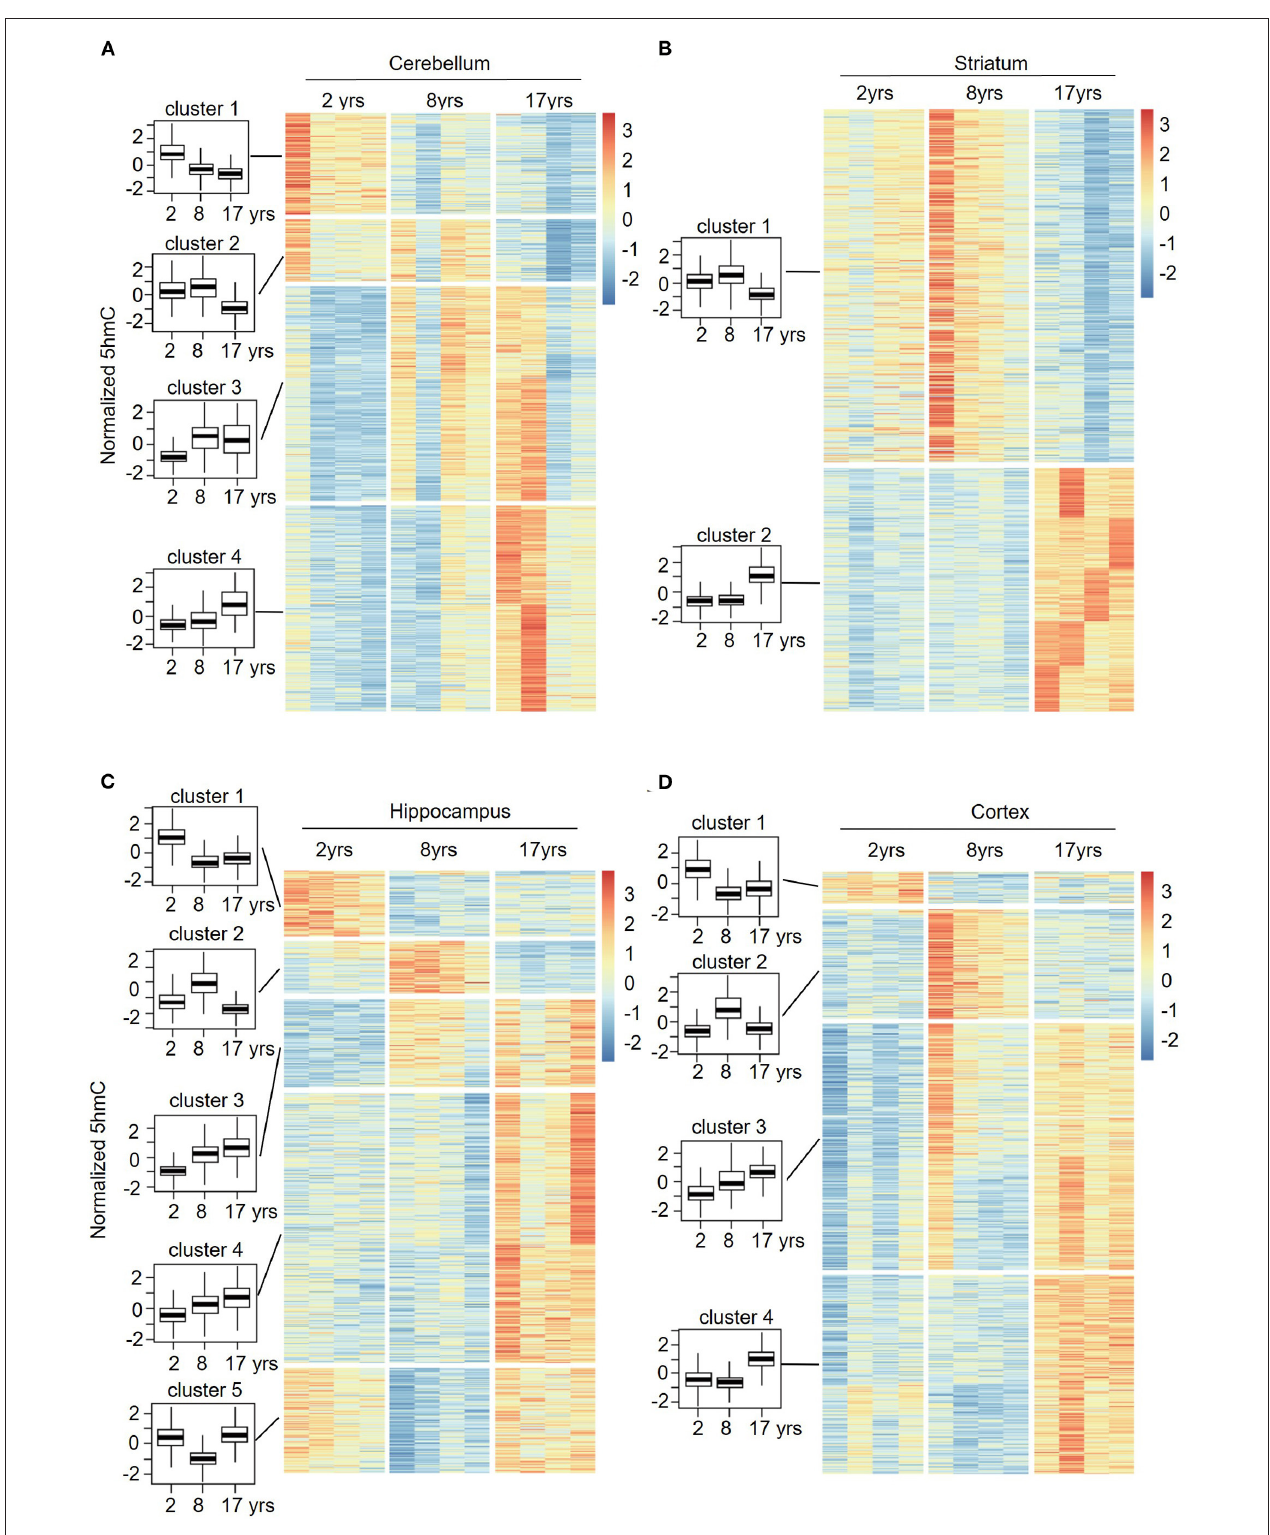
FIGURE 6 | Sequential features of 5hmC at cerebellum (A) , striatum (B) , hippocampus (C) , and cortex (D) during aging. Time-series analysis revealed 4 clusters in the cerebellum (A) , 2 clusters in the striatum (B) , 5 clusters in the hippocampus (C) , and 4 clusters in the cortex (D) from young to old.